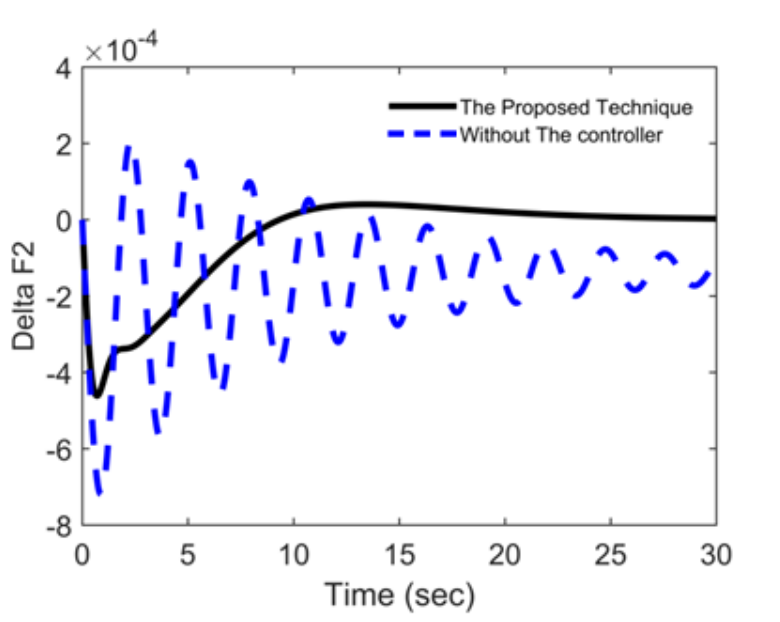
Figure 4. Frequency deviation (p.u.) in area 2.